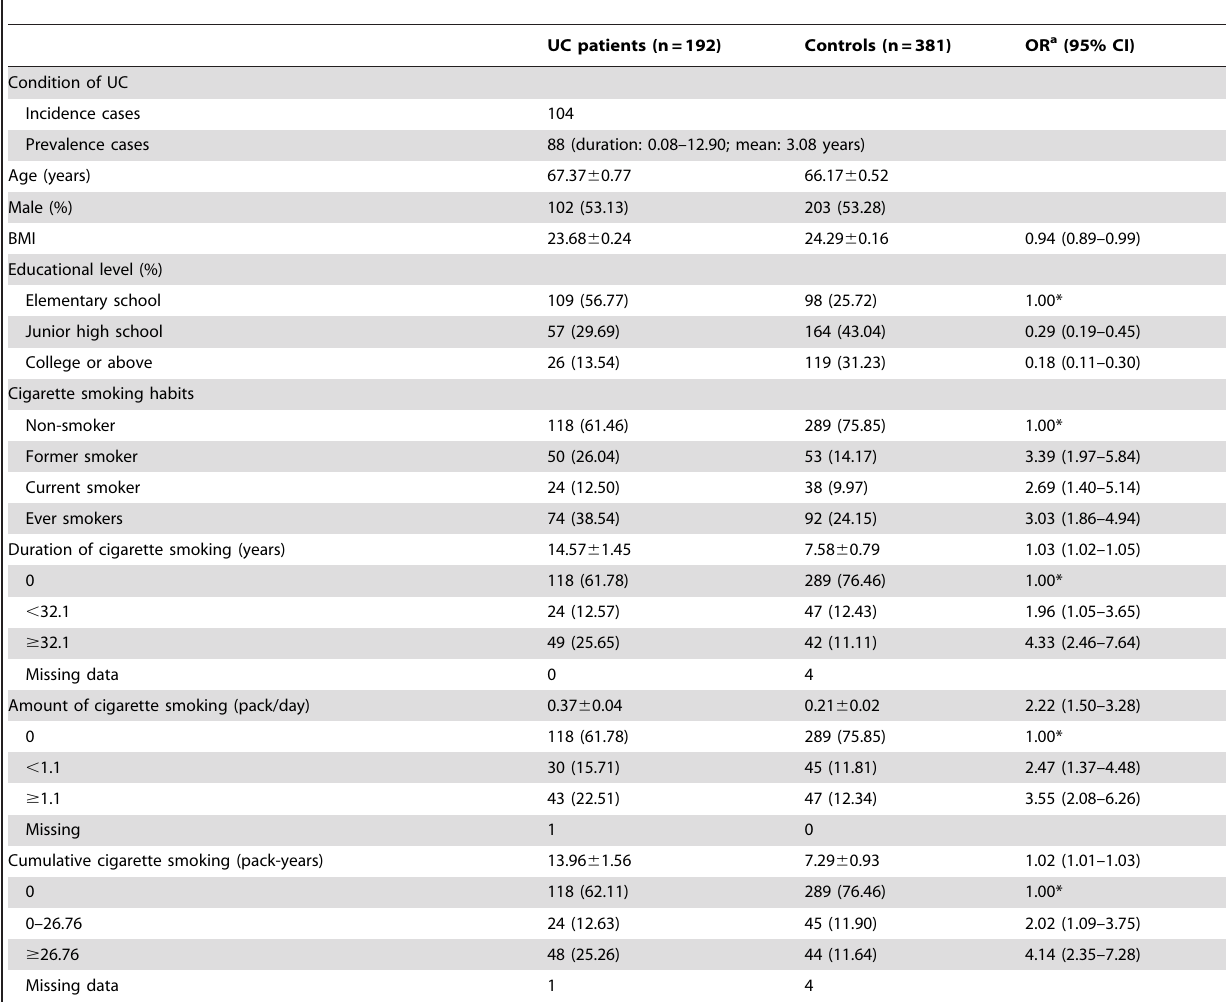
Table 1. Sociodemographic and clinical characteristics, as well as cigarette smoking habits of 192 UC patients and 381 matched